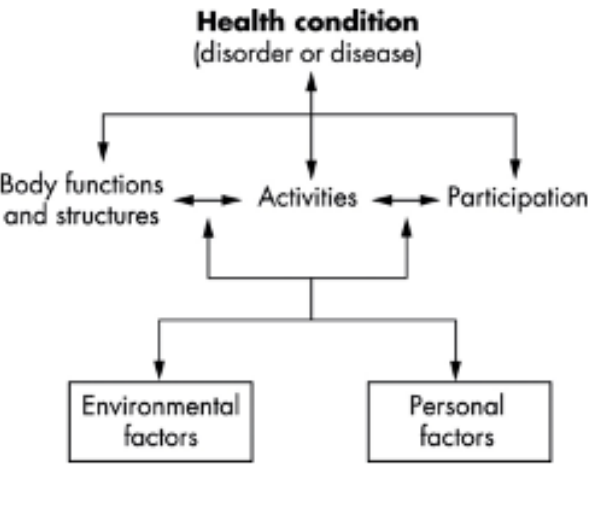
Figure 2. World Health Organization International Classification of Functioning framework.